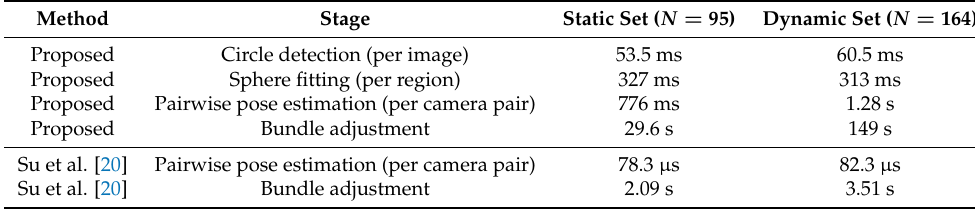
Table 2. Average computation time of the proposed method and Su et al.